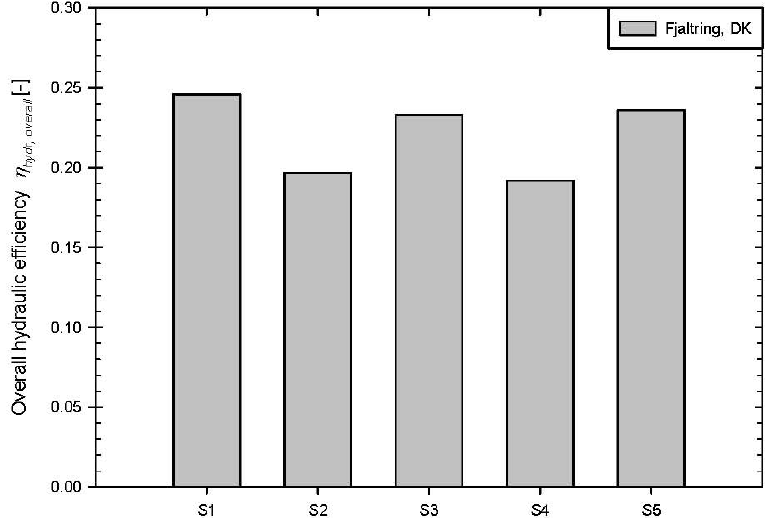
Figure A2. Comparison between effects of five scenarios on the overall hydraulic power for test site in Fjaltring, Danish Continental